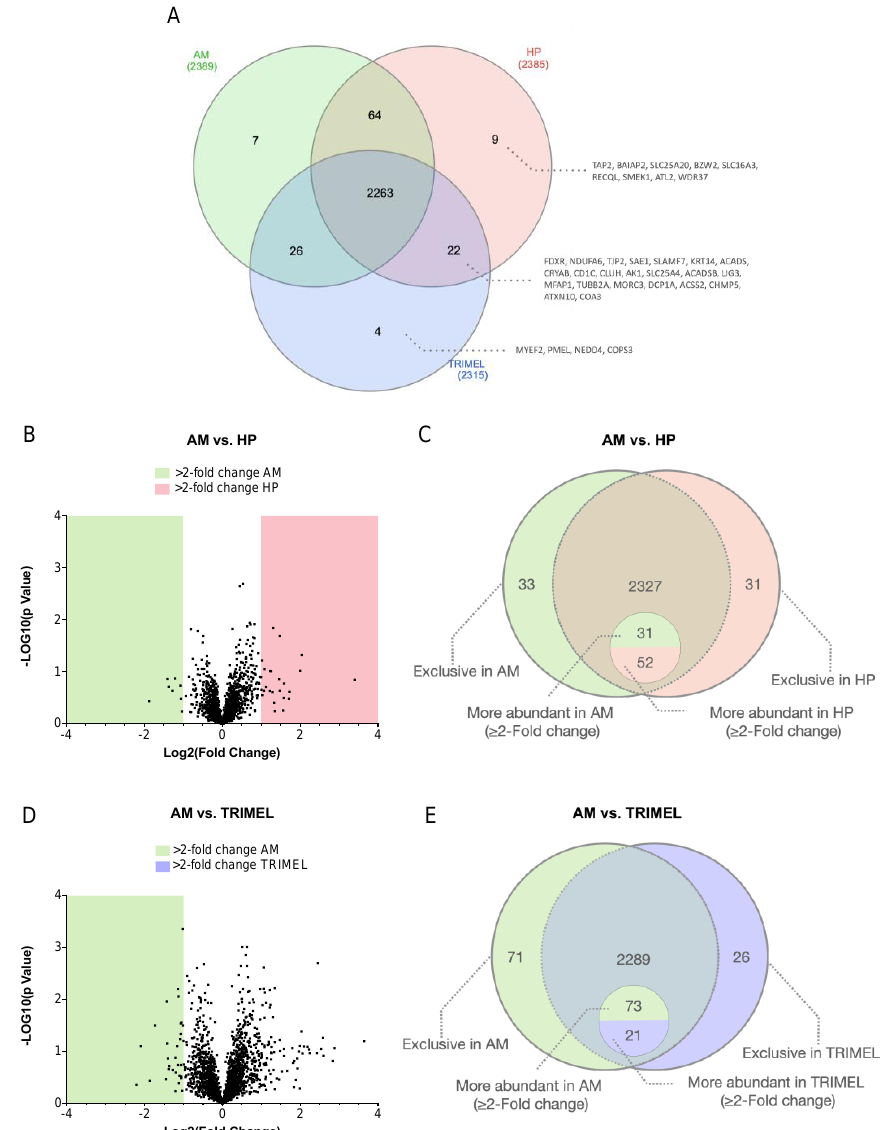
Figure 1. Qualitative and quantitative proteomic comparison of AM, HP-, and TRIMEL-stimulated cells. ( A ) The Venn diagram of the identified proteins shows that a total of 2395 proteins were identified. In addition, 2263 proteins were present in the three studied conditions. Furthermore, 22 proteins were simultaneously found in HP- and TRIMEL-stimulated cells; 64 in HP and AM; and 26 in TRIMEL and AM cells. Nine proteins were exclusively identified in HP-stimulated cells, four in TRIMEL-stimulated cells, and seven in AM cells. ( B ) Volcano Scatter Plot of the proteins with the highest abundance ( ≥ 2 fold-change) from AM vs. HP, and ( C ) AM vs. TRIMEL. The plots were constructed based on the variation in the fold change of each protein (Log2) and the p -value ( − Log10) when comparing both groups. ( D ) Representation of the exclusive and more abundant ( ≥ 2 times) proteins between HP and AM cells. In addition, 2327 proteins were present in both groups. Of them, 52 proteins were more abundant in HP samples and 31 in AM and 31 proteins were only identified in HP and 33 in AM; ( E ) representation of the exclusive and more abundant proteins between TRIMEL and AM cells. A total of 2289 proteins were found in both groups. Twenty-one proteins were more abundant in TRIMEL samples and 73 in AM cells. Twenty-six proteins were exclusively identified in TRIMEL-stimulated cells and 71 in AM